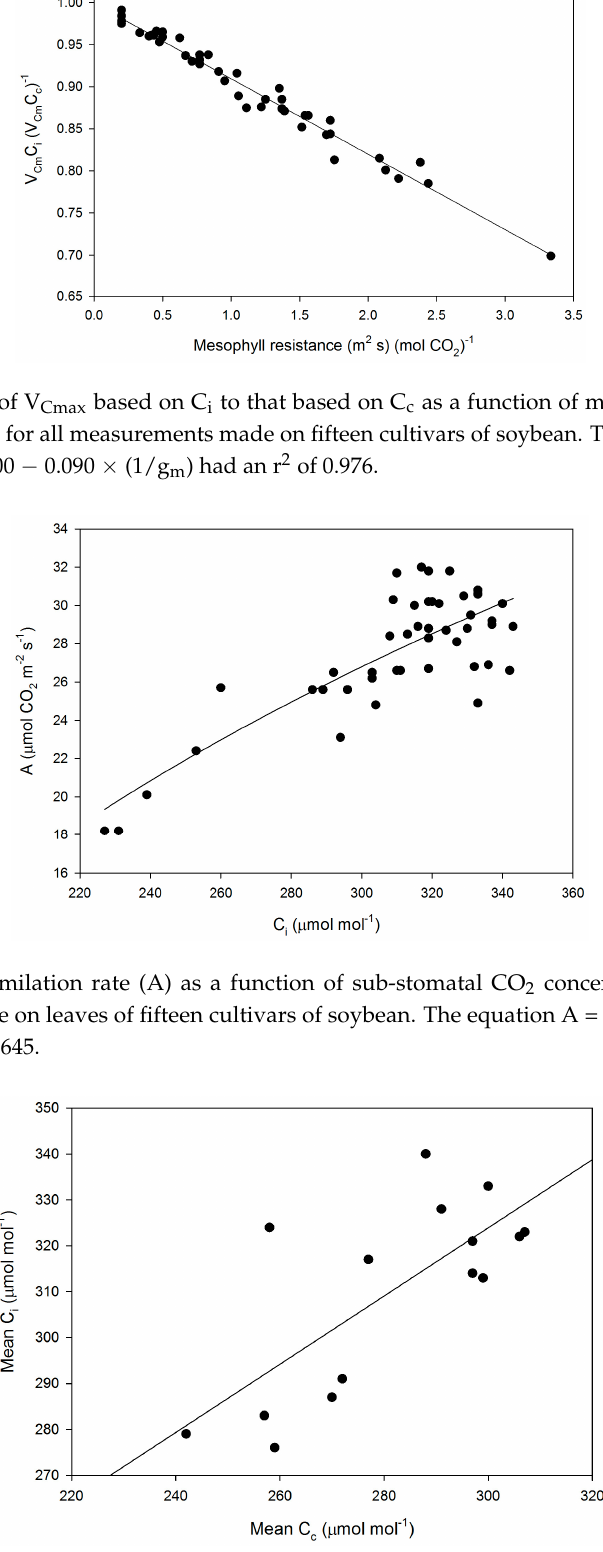
Figure 7. Cultivar mean values of C i versus mean values of C c . The linear regression had an r 2 value of 0.532.